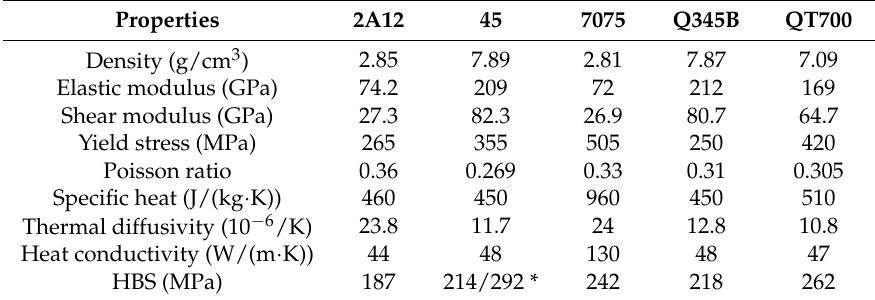
Table 1. Material properties of friction pairs consisting of metal tips and sliders. Properties